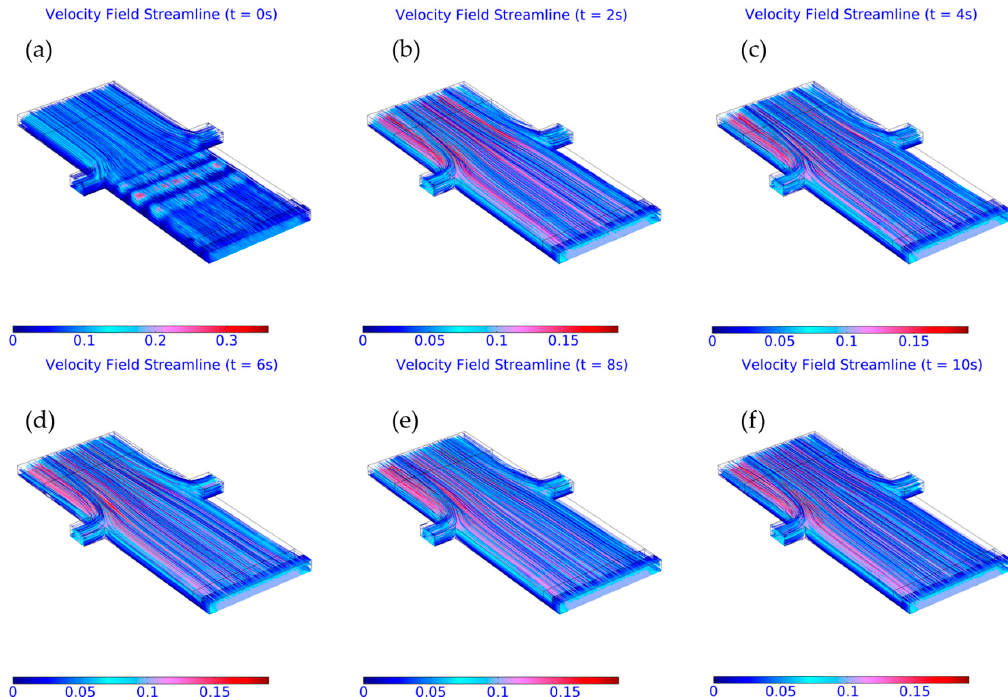
Figure 10. Distribution of velocity streamlines over the mixing chamber without obstacles at: ( a ) 0 s; ( b ) 2 s; ( c ) 4 s; ( d ) 6 s; ( e ) 8 s; and ( f ) 10 s. Different velocities are represented by different colors as shown in the color bar (in m s − 1 ).